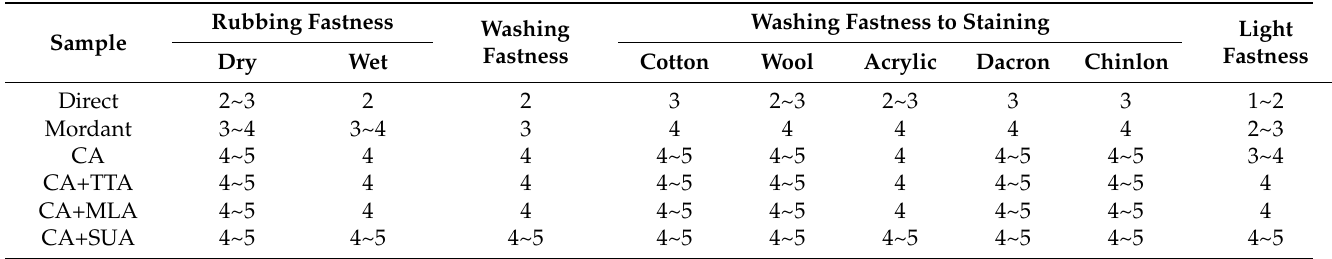
Table 4. Color fastness of the dyed cotton fabrics.